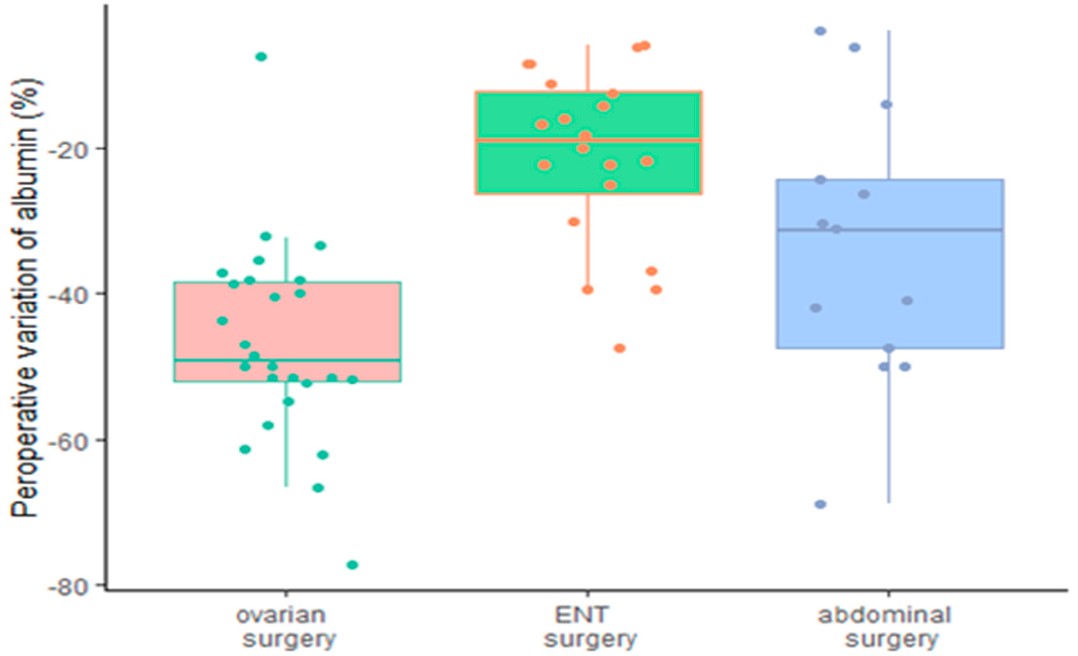
Figure 2. Maximum intraoperative albumin variation. The percentage of variation of serum albumin is represented in boxplots, the decrease was significantly less important in ABD and ENT group overall. The AUC comparison detect a significant difference between ENT and DBK group. The AUCs of intraoperative hemoglobin loss did not differ between the three groups, with an AUC of 0.05 [0–0.27] in the DBK group, 0.03 [0–0.28] in the ABD group, and 0.08 [0–0.15] in the ENT group (Figure